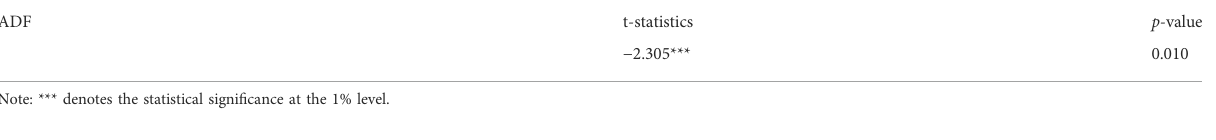
TABLE 9 The Pedroni cointegration test results.